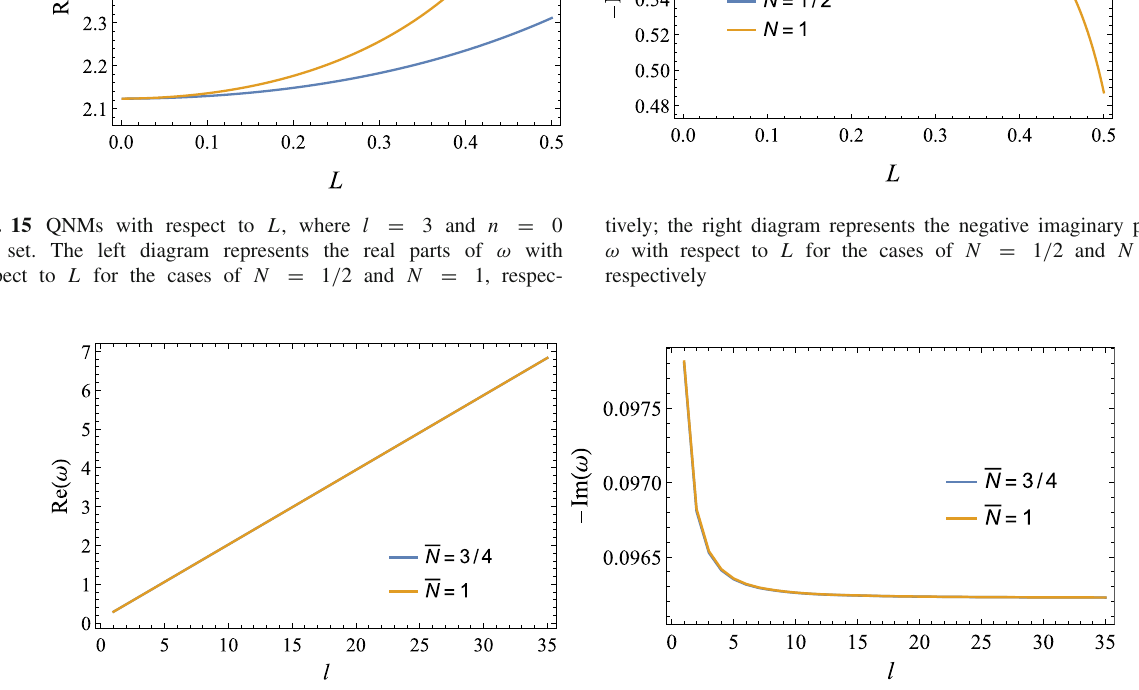
diagram represents the negative imaginary parts of ω with respect to l for the cases of ¯ N = 3 / 4 and ¯ N = 1, respectively. Note that the curves of the two cases are almost overlapped